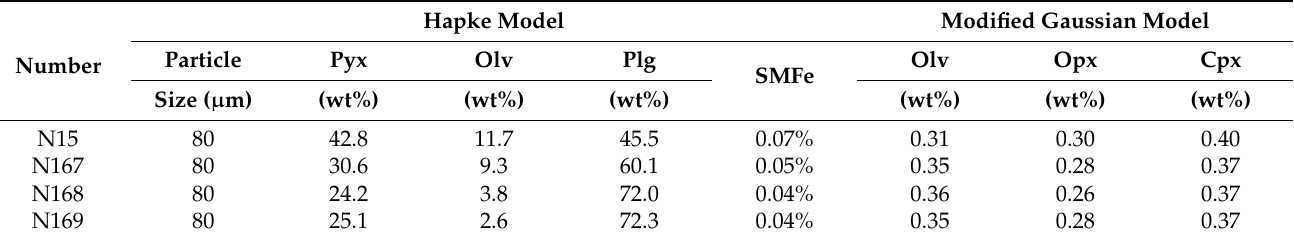
Table 1. Estimation of the Chang’e-4 rocks’ VNIS data.